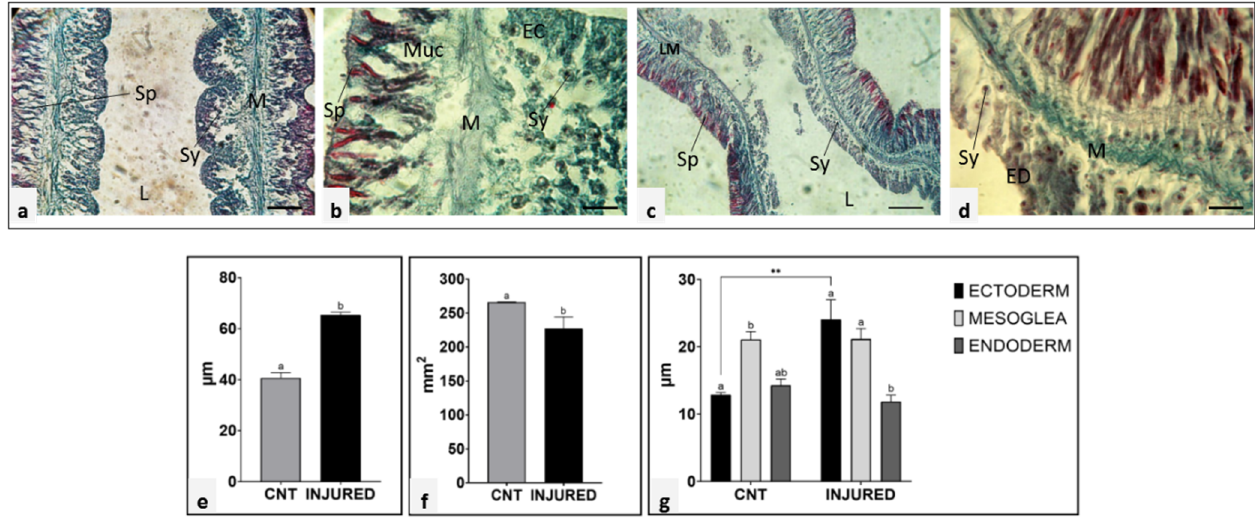
Figure 3. Gomori stain of tentacle transversal sections from uninjured specimens ( a , b ) and after 7 dpa ( c , d ). In light microscopy, Ectoderm (EC), Mesoglea (M), Endoderm (ED), Lumen (L), Spirocysts (Sp), Mucocytes (Muc), longitudinal muscle (LM), and Symbiodinium symbiont (Sy) were identified. The different dimensions of the tissue layers are evident in the magnifications of the sections of the control ( c ) and amputated ( d ) tentacles. Bars—50 ( a , c ) and 100 µm ( b , d ). Plots report that the biometric quantification of tentacular thickness increases ( e ) and the lumen decreases ( f ) in regenerating organisms post-amputation (injured) compared to the unamputated specimens (cnt). ( g ) shows the thickness of three body layers (ectoderm, mesoglea and endoderm). The Mesoglea and the Endoderm maintain constant size while the ectodermal layer increases in injured specimens with respect to the control (cnt). Analysis of variance was carried out. The letters (a,b) indicate statistically significant differences between control and its respective treated group. * Indicates differences between groups at each time. Significant differences were detected by Tukey post hoc test—** p <